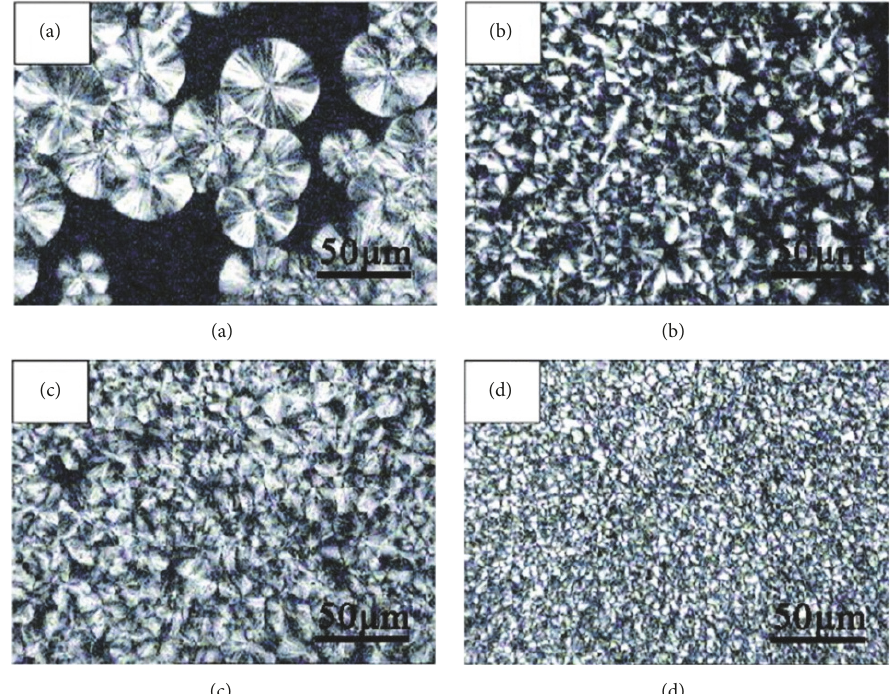
Figure 7: Optical micrographs of neat PLA and PLA/MOF (metal oxide framework) composites: (a) PLA, (b) PM0.5, (c) PM1, and (d)